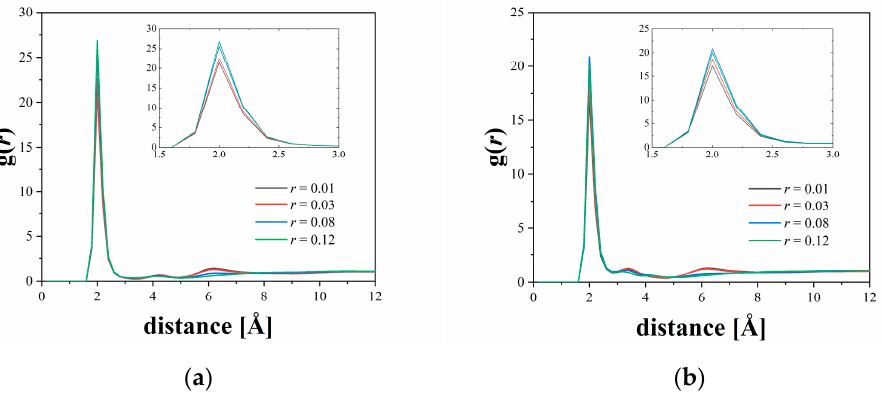
Figure 3. Radial distribution function between Li ions and polymer oxygen atoms at various salt concentrations for ( a ) PEO and ( b ) P(2EO-MO). The insets are magnified view of the first peak.